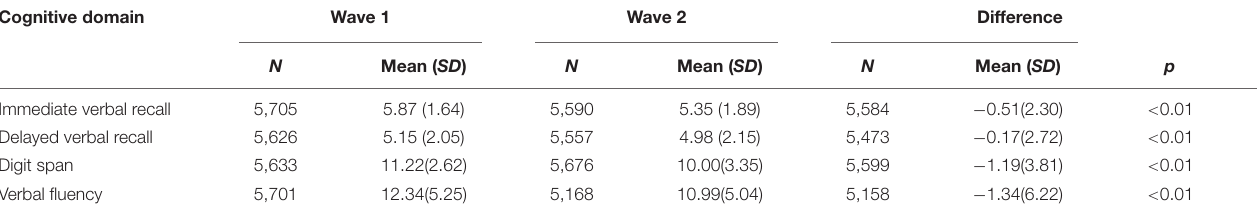
TABLE 2 | Comparisons of cognitive scores at Wave 1 and Wave 2. Cognitive domain Wave 1 Wave